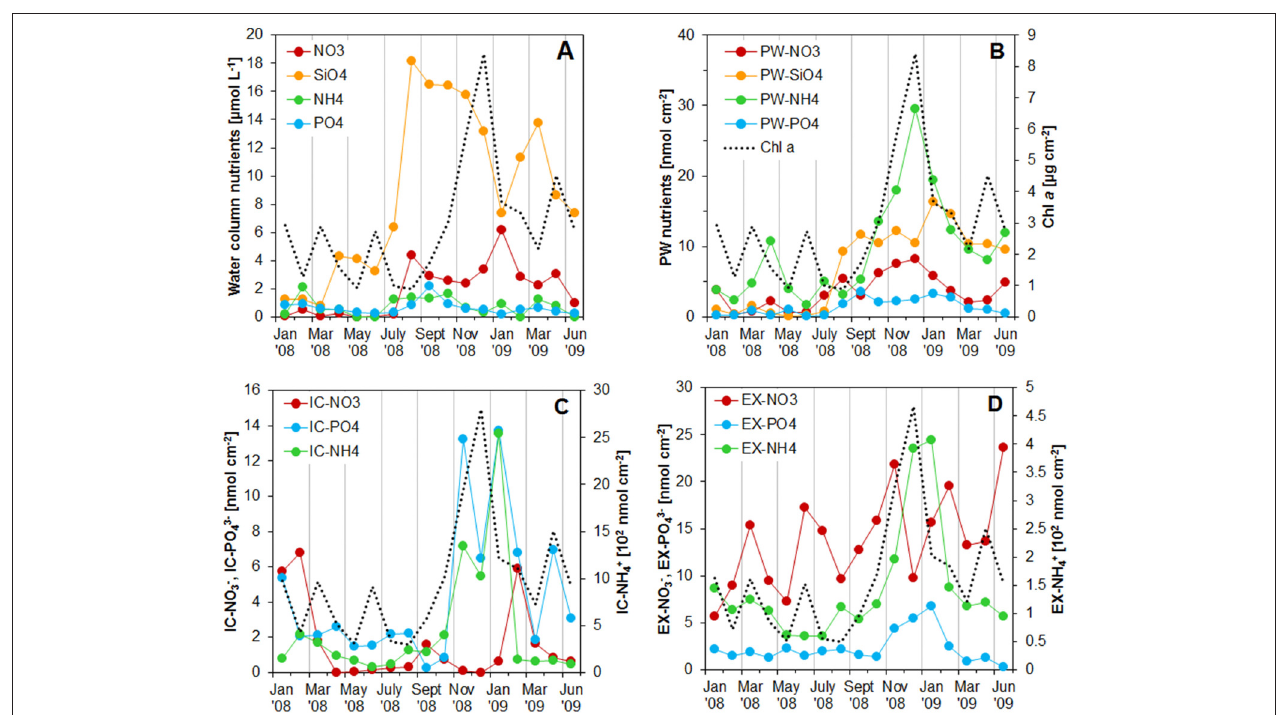
FIGURE 3 | (A) Concentration of nutrients in the water column at the sampling station on Trocadero Island, Bay of Cádiz, from January 2008 to June 2009. (B–D) Integrated nutrient pools in the first 4 mm of the sediment: (B) porewater, (C) intracellular, and (D) exchangeable pools. Integrated Chlorophyll a content was also drawn in all the graphs for comparison. Notice the different scale (10 2 nmol cm − 3 ) for intracellular and exchangeable ammonium pools in C and D .